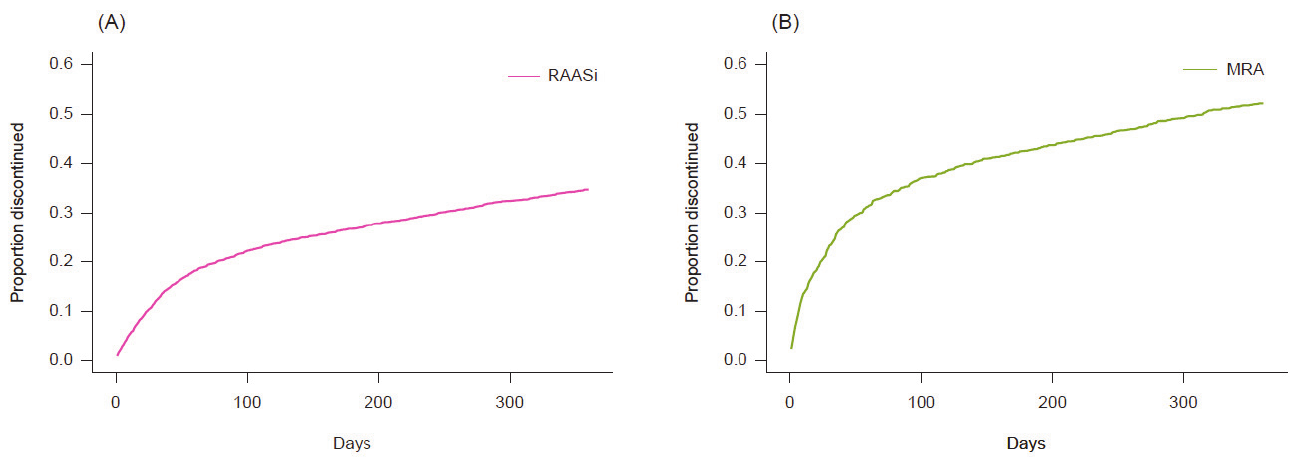
Figure 2. RAASi and MRA cessation rates within 12 months of the index date. ( A ) RAASi cessation ( n = 5059). ( B ) MRA cessation ( n = 2220). Abbreviations: MRA, mineralocorticoid receptor antagonist; RAASi, renin–angiotensin–aldosterone system inhibitor.